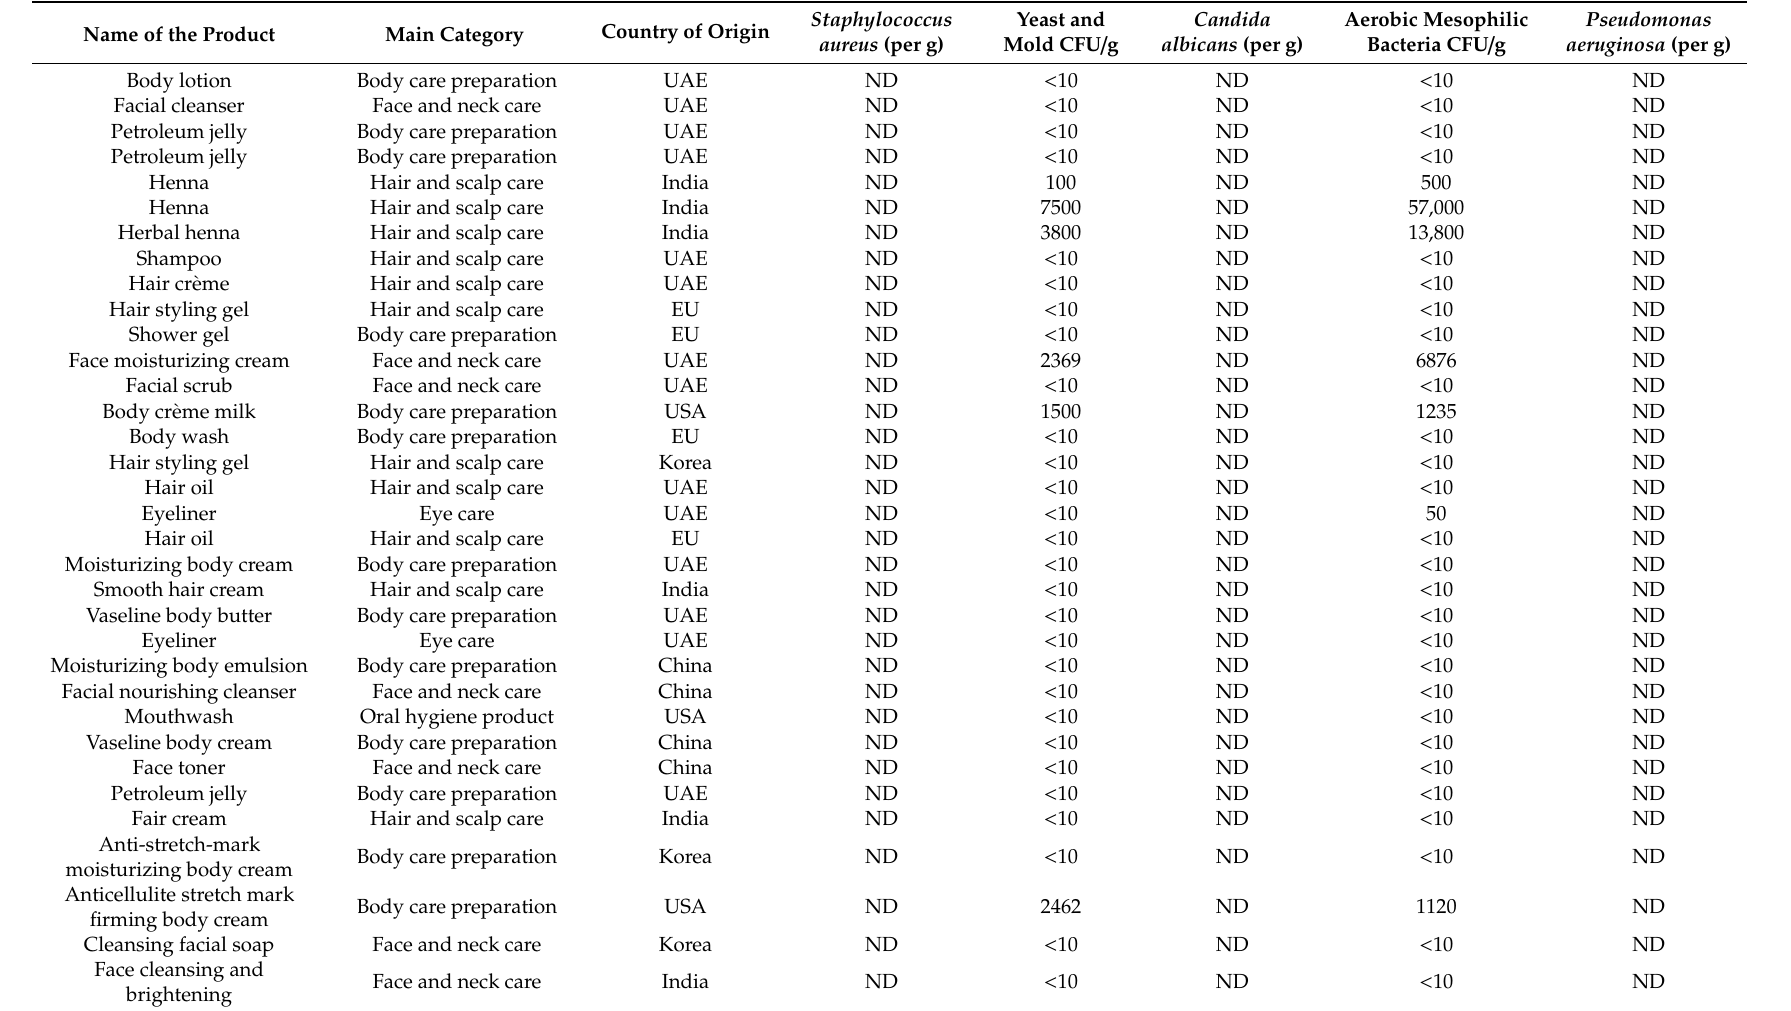
Table 4. List of tested cosmetics and personal care products according to microbial contamination and sample